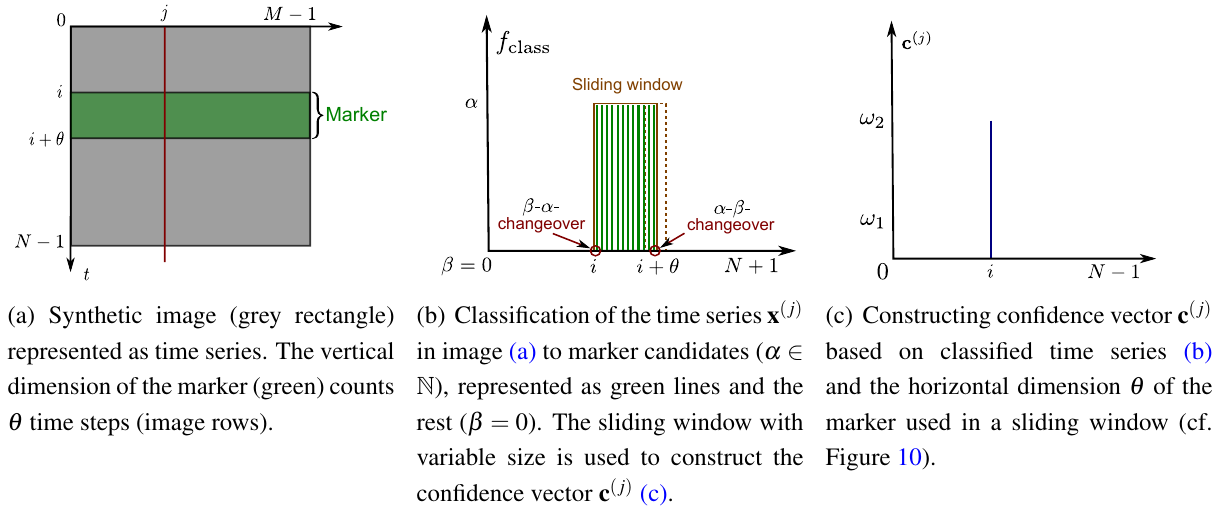
Figure 11. Classification of time series x ( j ) of a synthetic image shown in ( a ) to marker candidates ( α ∈ N ) and no marker time steps ( β = 0). The subsequent process of constructing a confidence vector c ( j ) based on ( b ) is depicted in ( c